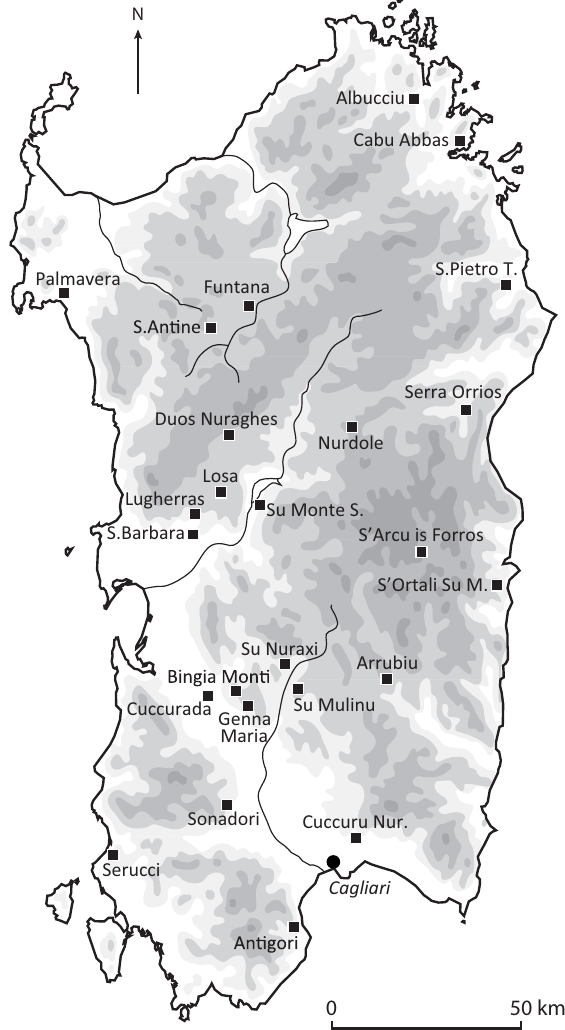
Figure 1: Map of Sardinia with main sites mentioned in the